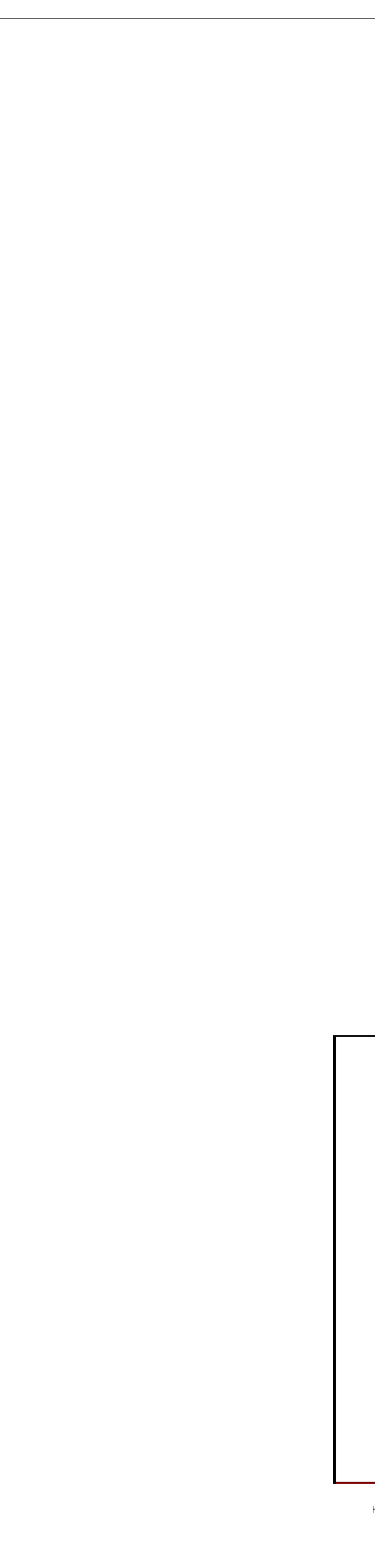
Frontiers in Cellular and Infection Microbiology |